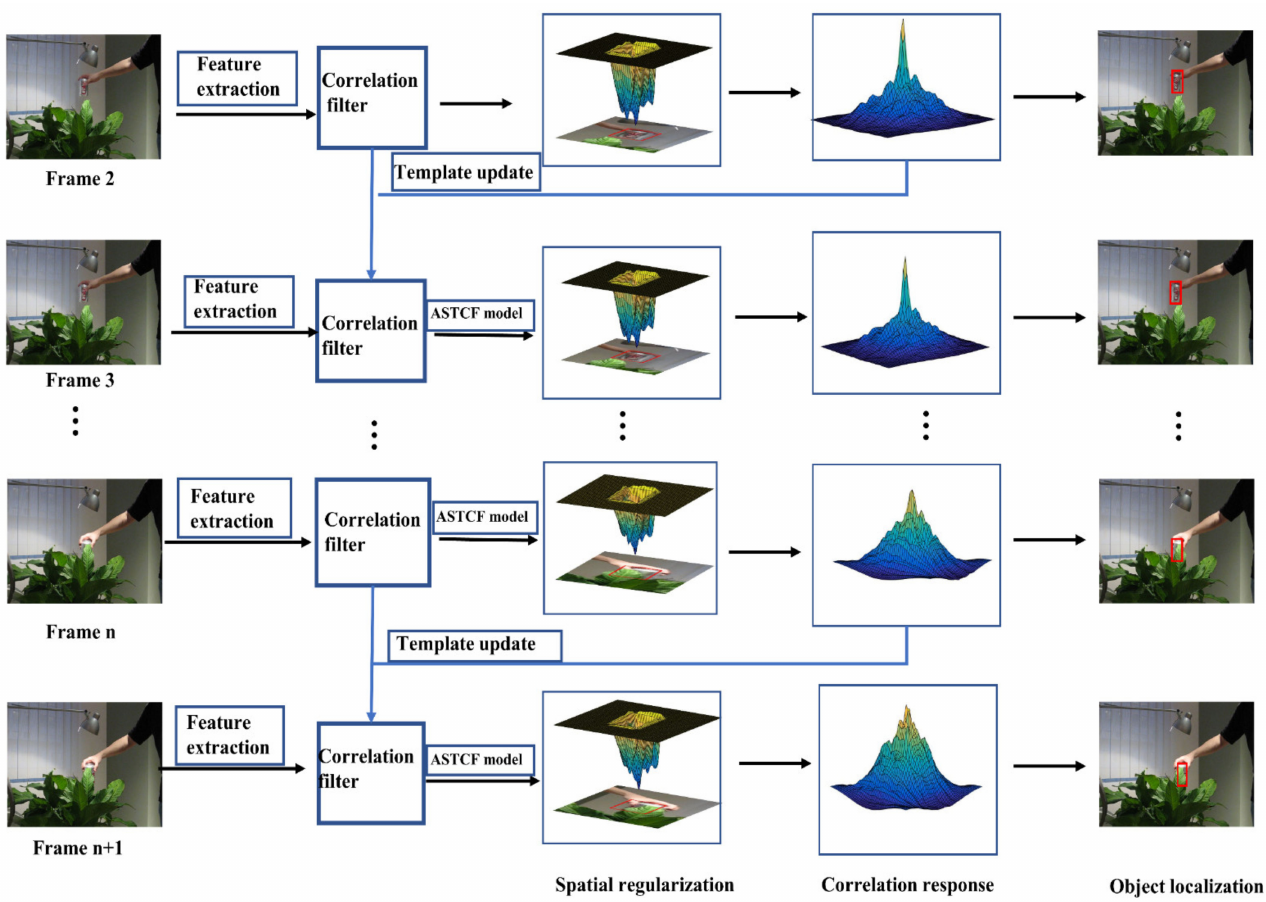
Figure 2. The framework of adaptive spatial regularization and temporal-aware. Red bounding-boxes donate the final